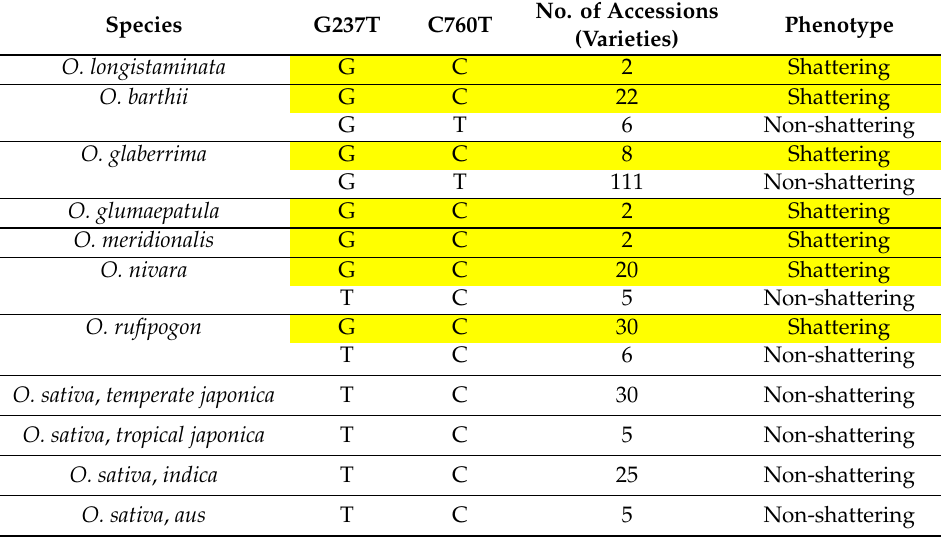
Table 1. The haplotypes of the SH4 at G237T and C760T sites in the AA genome species of genus Oryza. No. of Accessions Species G237T C760T (Varieties)